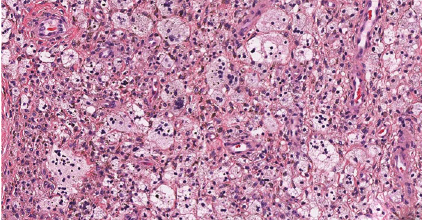
Figure 4: Histology images in the hip post-pexidartinib treatment. The posttreatment specimen was less cellular compared to the pretreatment tissue and demonstrated a relative increased number of foamy histiocytes and signi fi cantly decreased number of multinucleated giant cells (H&E